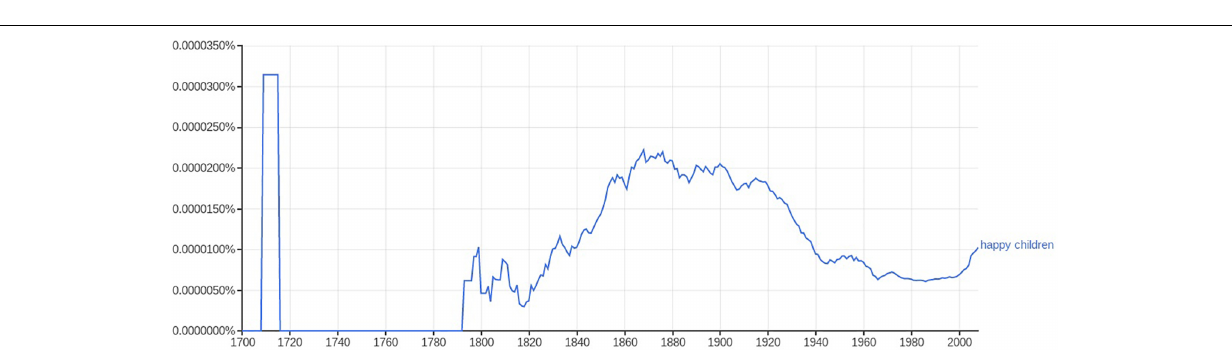
FIGURE 1 | Frequency of the word “happiness” in American English, 1700–2008, Google Ngram viewer, accessed March 19, 2019.